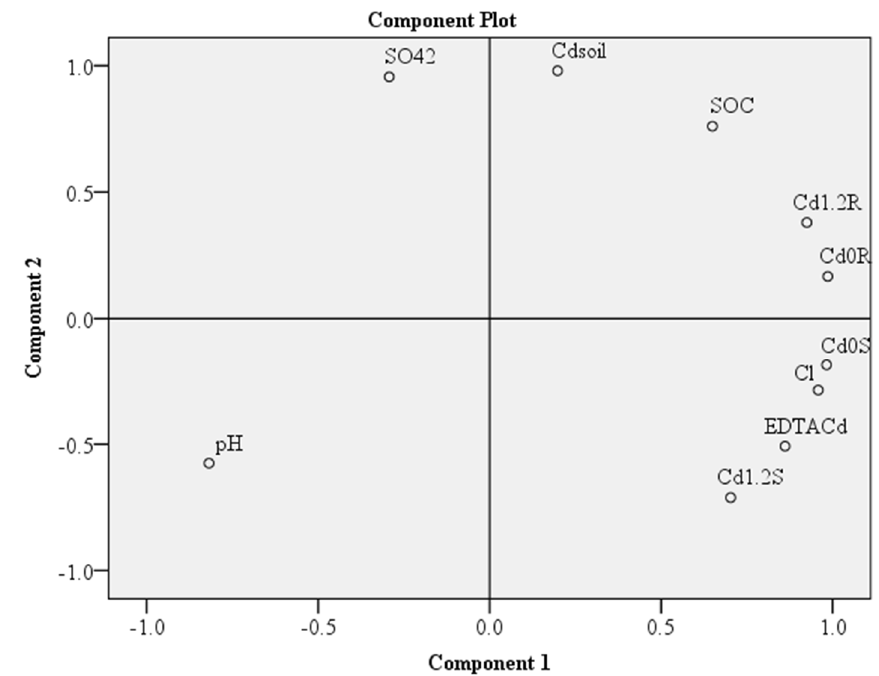
Figure 5. PCA analysis for long term experiment exhibited biplots for total 10 variables which showed that the first principle component (PC1) accounted for 61.2% and the second principle component (PC2) accounted for 38.7%. pH = soil pH, SOC = soil organic carbon, EDTA Cd = EDTA extractable Cd in soil, Cl = total Cl − contents in soil, SO42 = total SO 42 − content in soil, Cd0R = total Cd in rice root under Cd0 exposure, Cd1.2R = total Cd in rice root under Cd0 exposure, Cd0S = total Cd in rice shoot under Cd0 exposure, Cd1.2S = total Cd in rice shoot under Cd1.2 exposure.